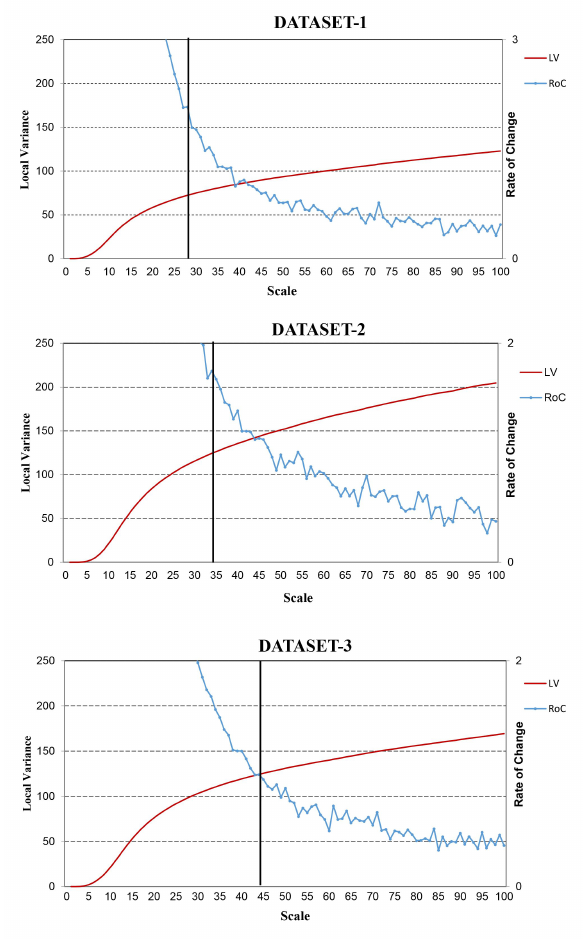
Figure 3: Optimal scale parameter selection using ESP-2 tool for all